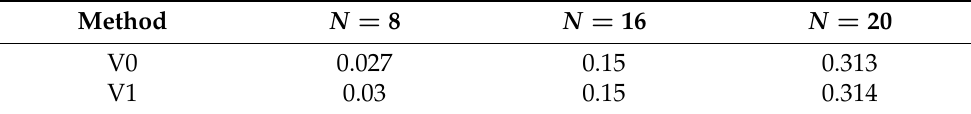
Table 4. Helmholtz 3D. CPU times (in seconds) for various number of quadrature points and representations. Times account for computing the solution from points A and B, for (cid:96) = 10 − k , k = 0,11 (cid:74) (cid:75)